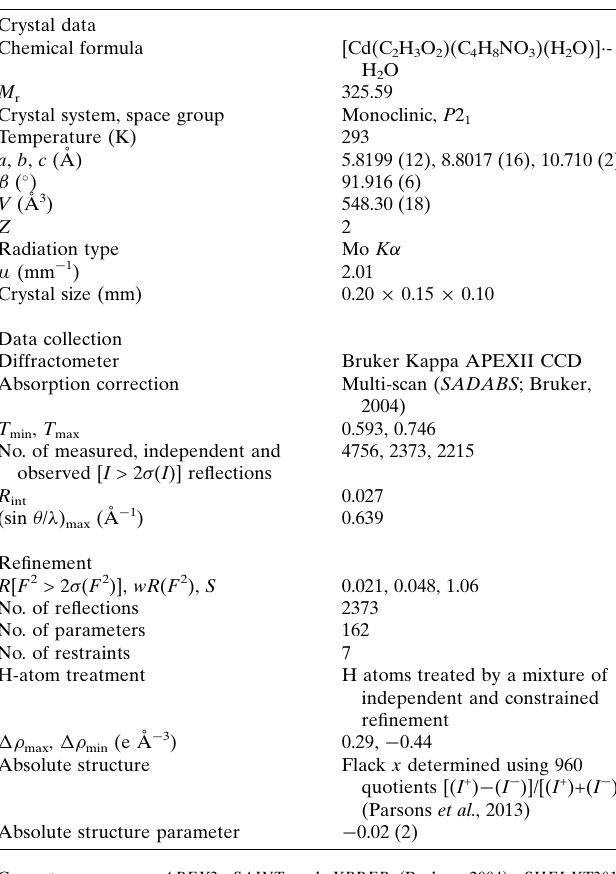
Table 1 Hydrogen-bond geometry (A˚ , (cid:4) ).